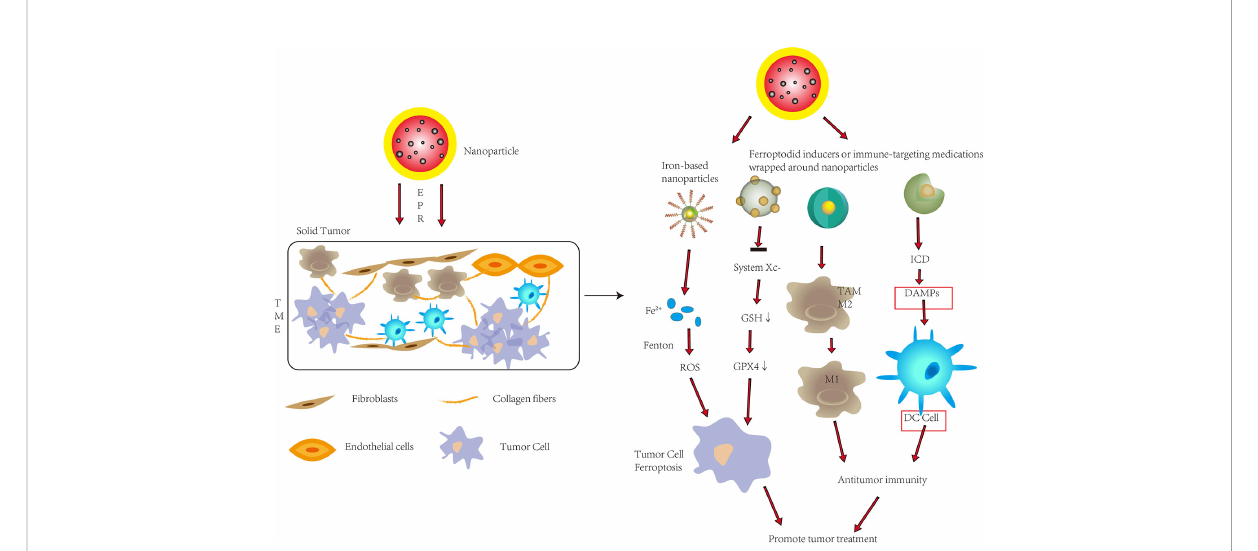
FIGURE 3 To improve tumor therapy, nanoparticles are used in ferroptosis and tumor immunity. Nanoparticles inside tumors can promote ferroptosis in tumor cells by releasing signi fi cant levels of Fe 2+ or suppressing System Xc-, allowing them to penetrate solid tumors through enhanced permeability and retention (EPR). Nanoparticles can also convert M2-type cells to M1-type cells inside tumors, improve immunogenic cell death (ICD), and promote DC cell maturation, all of which improve anti-tumor immunity. To improve tumor therapy, nanoparticles can trigger ferroptosis while also increasing antitumor immunity in solid tumors. DAMPs, Damage associated molecular